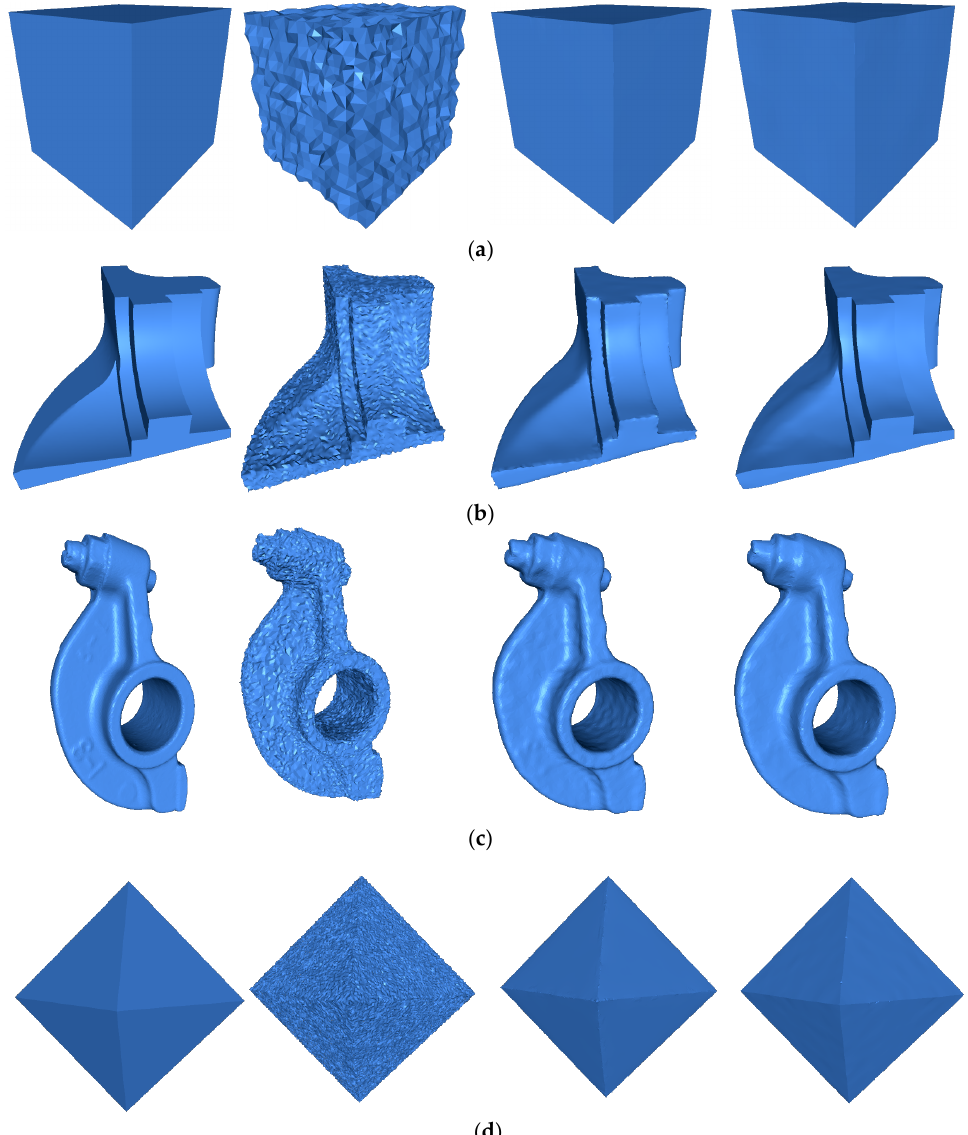
Figure 3. The first column shows the model from the original data. The second model is corrupted by Gaussian noise. The third column shows most accurate result of the comparison methods using MSE metric. The fourth column shows the result of correcting by the proposed method. The Gaussian noise levels and the comparison method are ( a ) Cube σ = 0.3h method CVN, ( b ) Fandisk σ = 0.28h method RN, ( c ) Rocker Arm σ = 0.3h, and ( d ) Octhaedron σ = 0.3h .